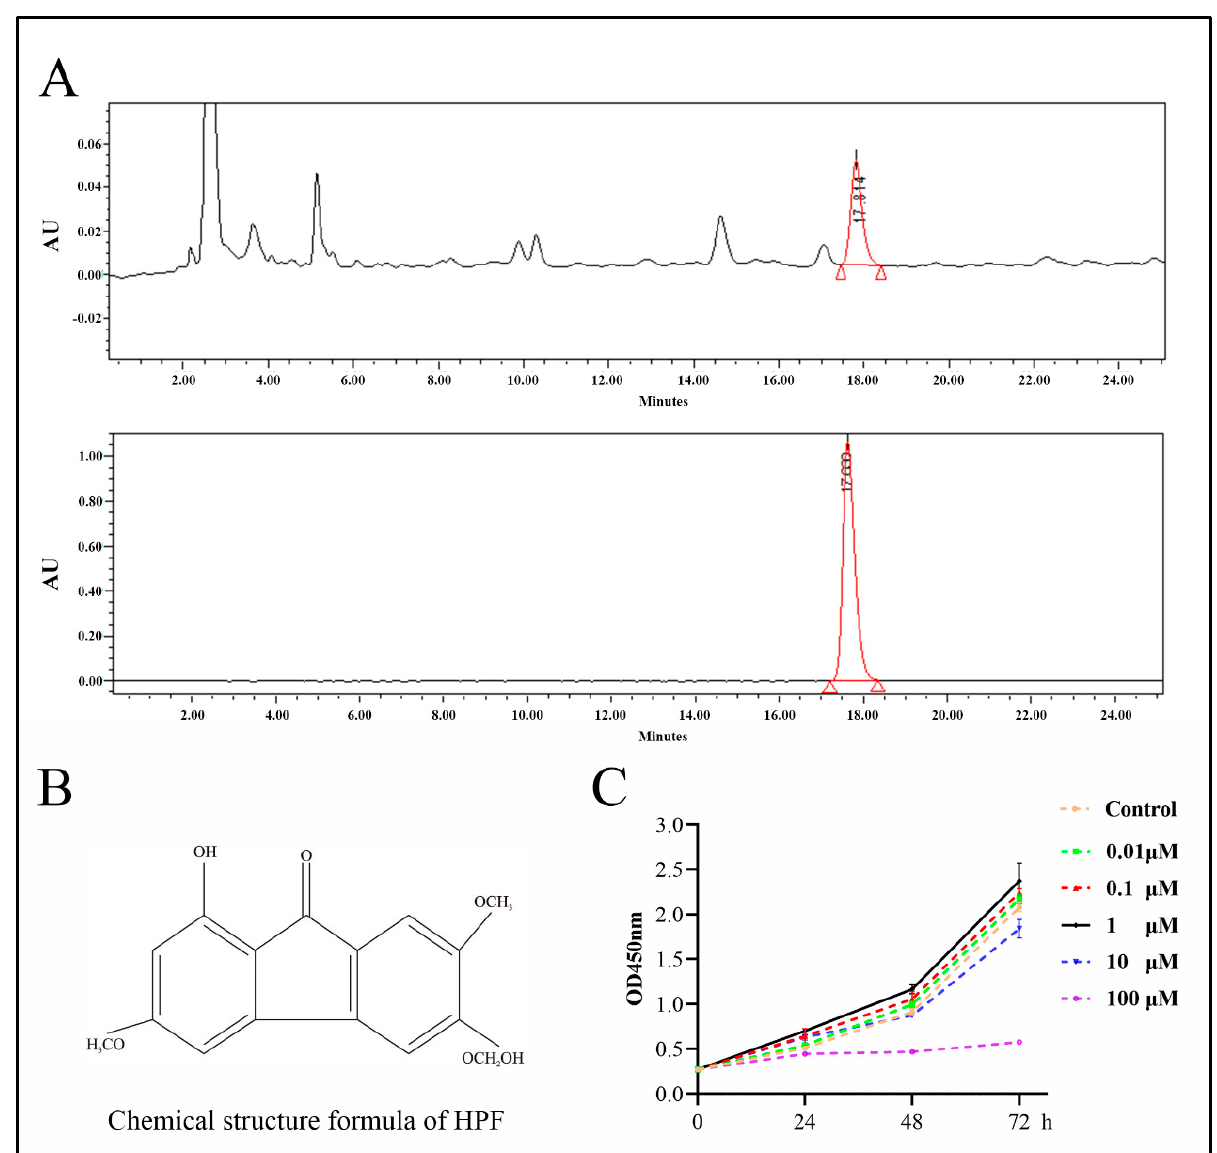
Figure 2. The chemical composition of HPF was determined by high-performance liquid chroma- tography (HPLC). ( A ) HPLC chromatogram of Herpetspermumb and HPLC chromatogram of HPF standard. ( B ) Chemical structural formula of HPF. ( C ) OD value distribution of HPF with different concentrations.